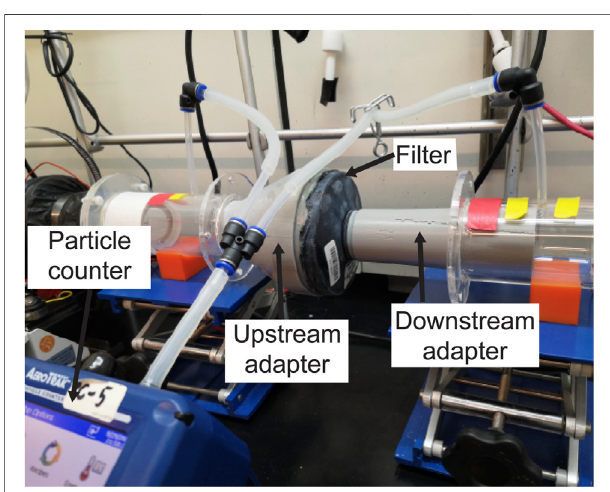
FIGURE 2 | Loading fi ltration test setup, with fi lter cartridge in line with KCl-containing air stream. Other components of the apparatus have been previously described (Plana et al.,